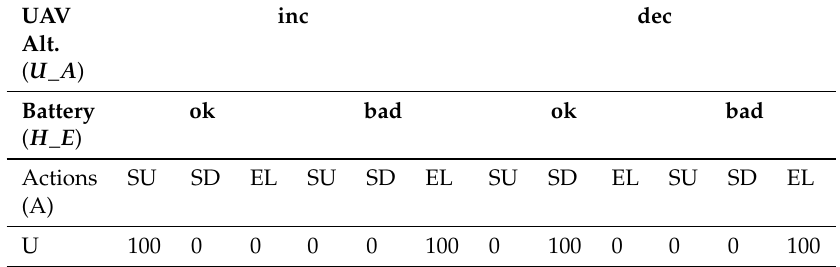
Figure 14. Decision Network (DN) example to make a decision between the different actions to choose (Speed UP, Slow Down, Emergency Landing) taking into account the state of the unmanned aerial vehicle (UAV) in altitude and the health status of the battery. Table 4. Utility table for decision making with DN associated with the actions Speed Up (SU), Slow Down (SD) and Emergency Landing